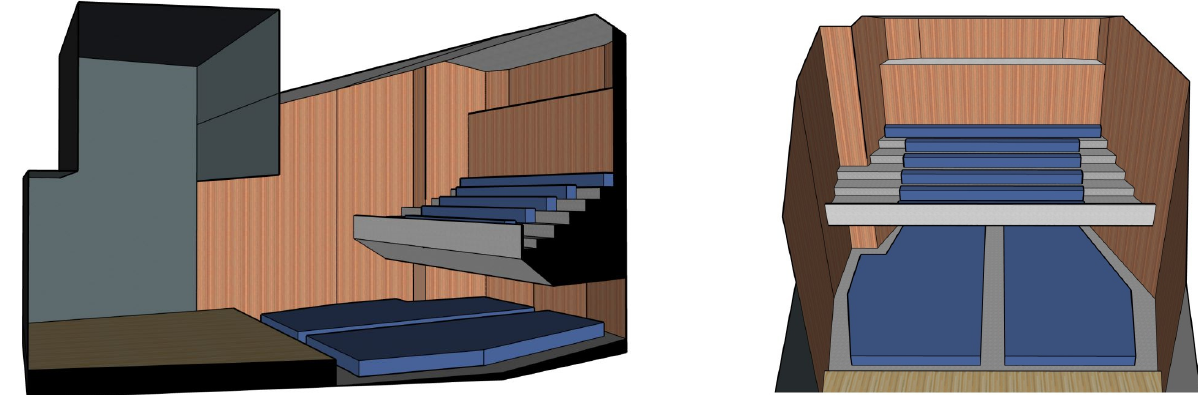
Figure 4. SketchUp 3D views of the geometrical model of the auditorium.